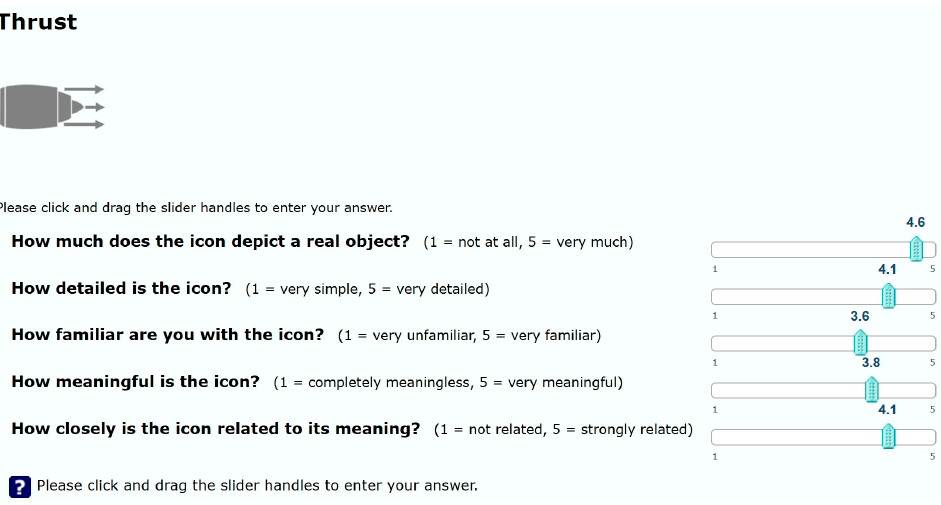
Figure 4. Example question from the second part of the questionnaire.